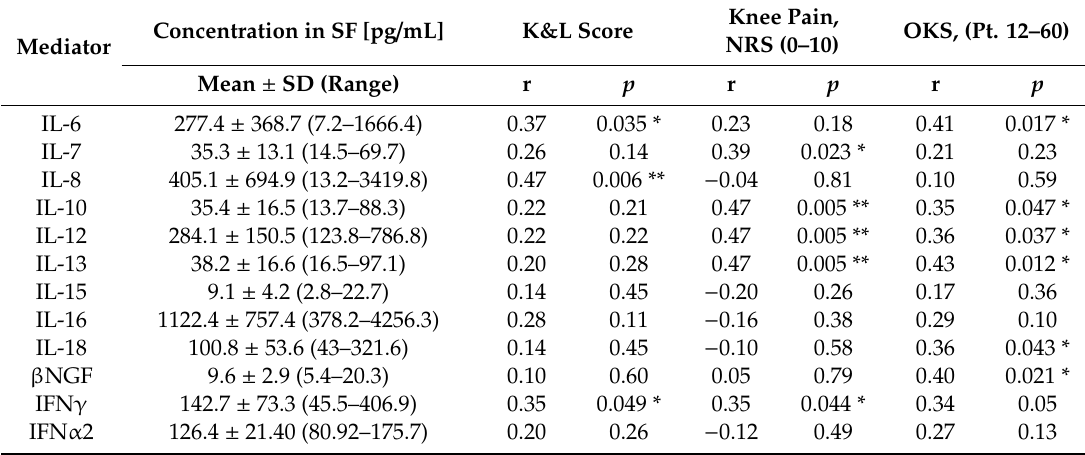
Table 2. Correlation analyses between inflammatory mediators in SF and clinical parameters.